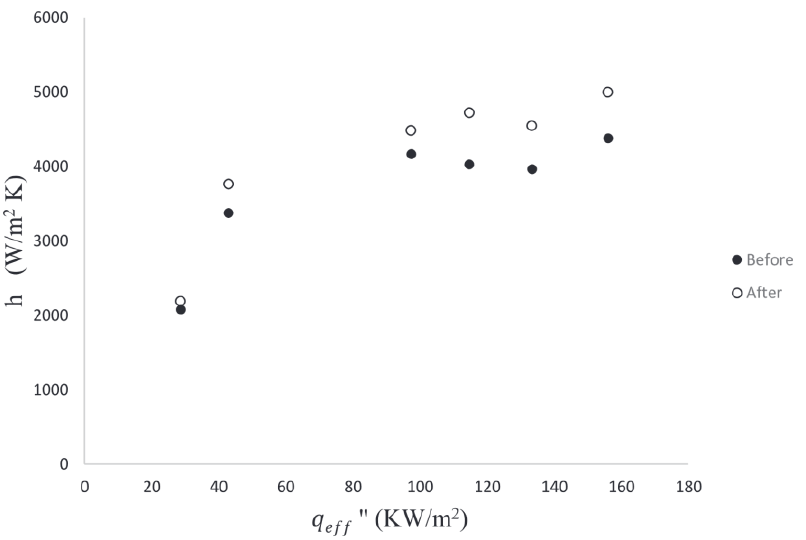
Figure 11. Heat transfer coefficient enhancement in the presence of synthetic jets at different heat fluxes as measured in [46].